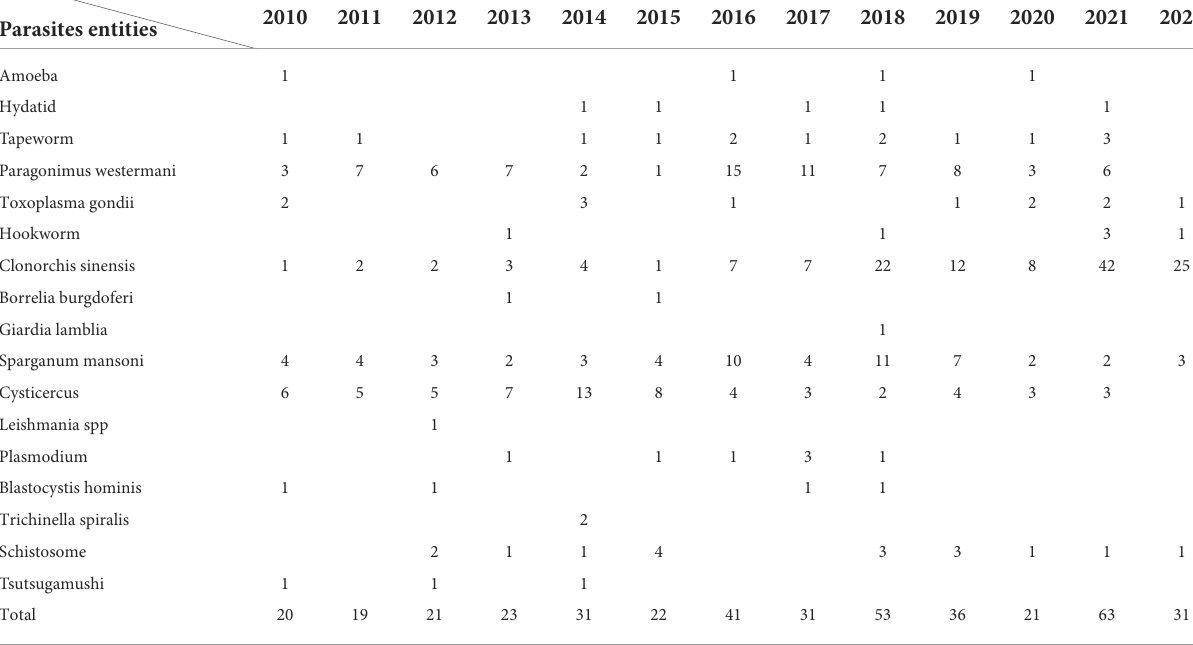
TABLE 1 Parasitic infections over recent 13 years in a tertiary hospital in Shanghai. entitiesYear Parasites